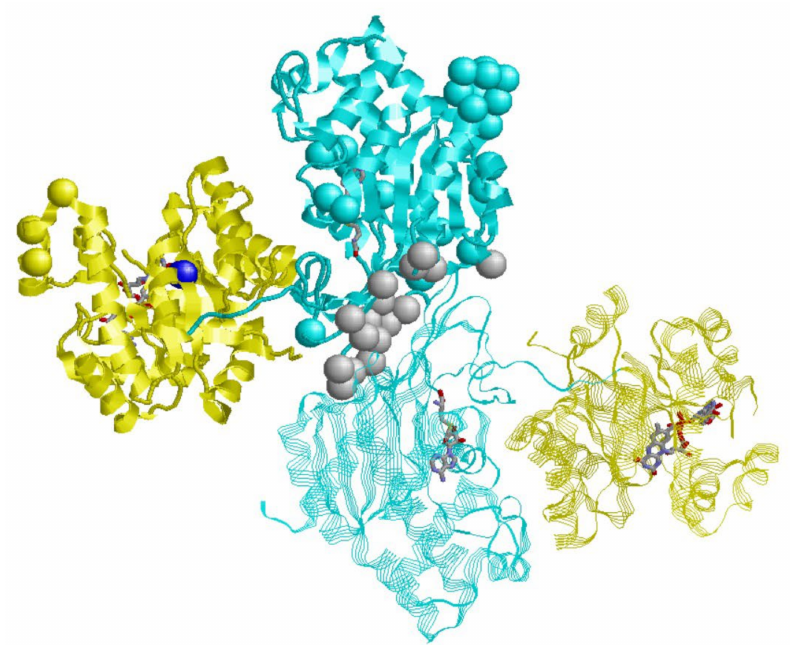
Figure 1. Protein-protein interaction sites predicted with ISPRED4 [10] on the MTHFR PDB 6FXC. The catalytic and regulatory domains are depicted in yellow and pale blue, respectively. Interaction sites are represented with hard spheres centered on the C-alpha atom of the specific residue. Grey spheres are residues in the homodimeric interface, correctly predicted as interaction